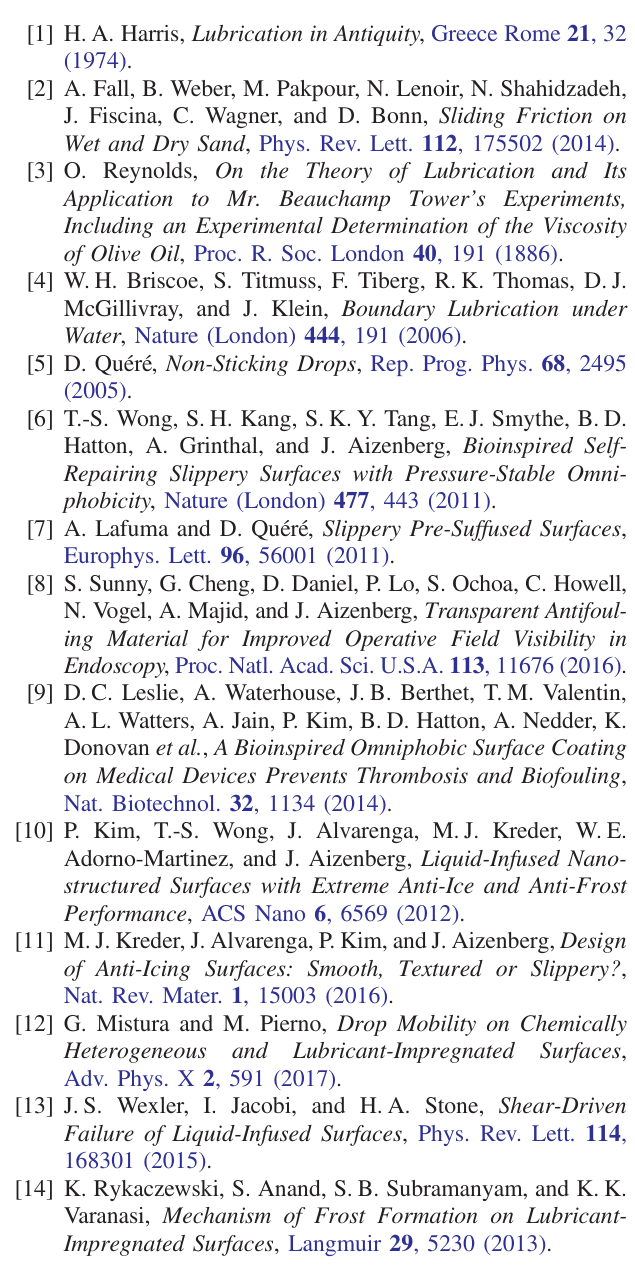
FIG. 13. Plot of h indicates the line of best fit for h droplets. The dashed line shows the approximate slope at high capillary numbers ( h